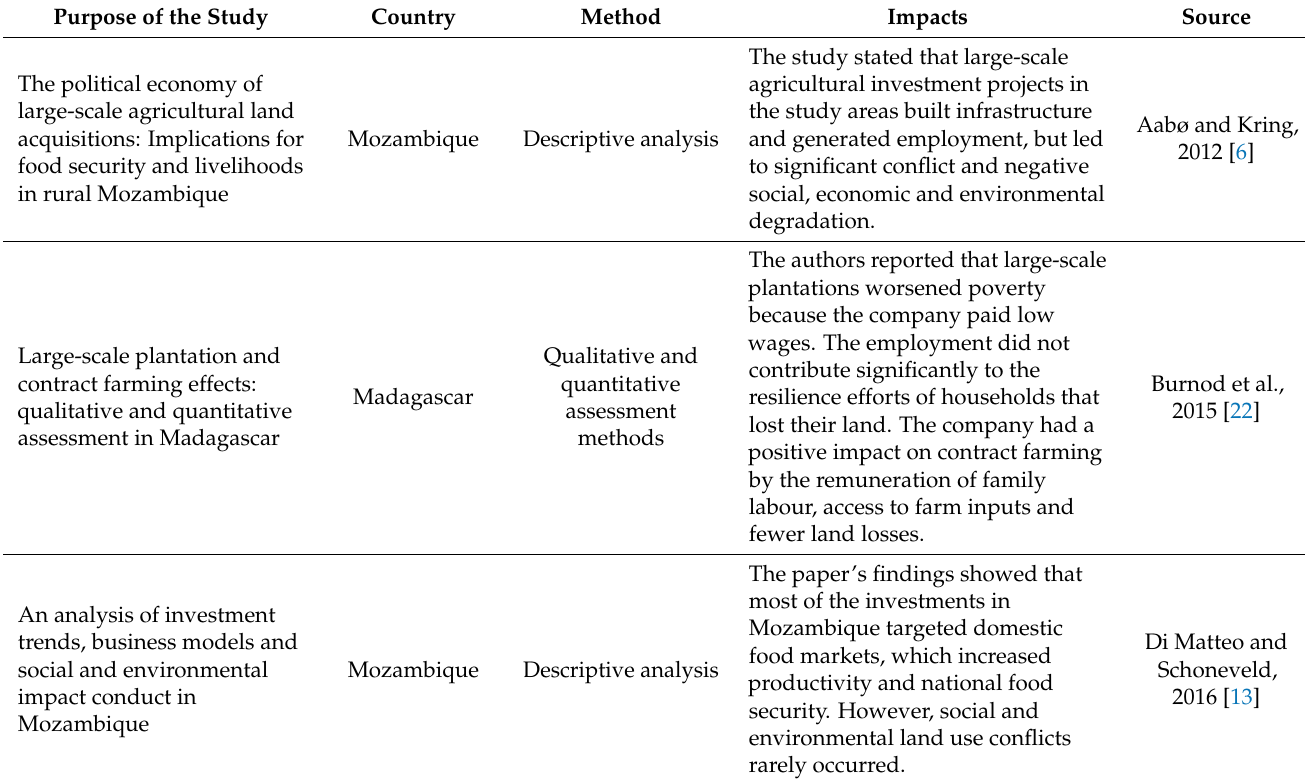
Table 1. Overview of case studies on LSAIs conducted in the study